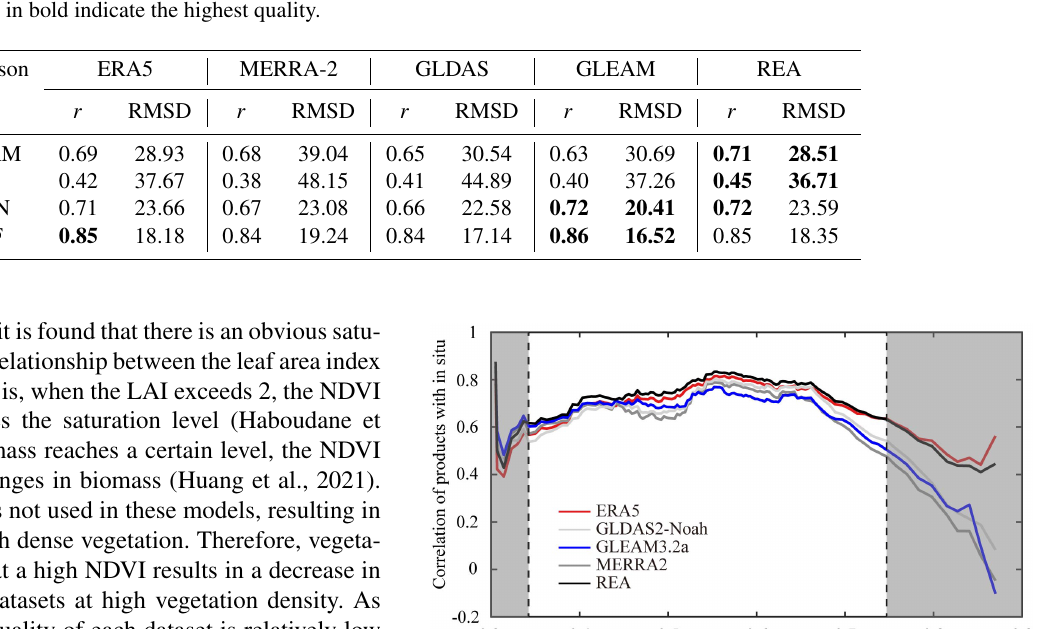
Table 5. The verification results including r and RMSD between monthly ground-measured ET and monthly ET from different products in different seasons. Values in bold indicate the highest quality.